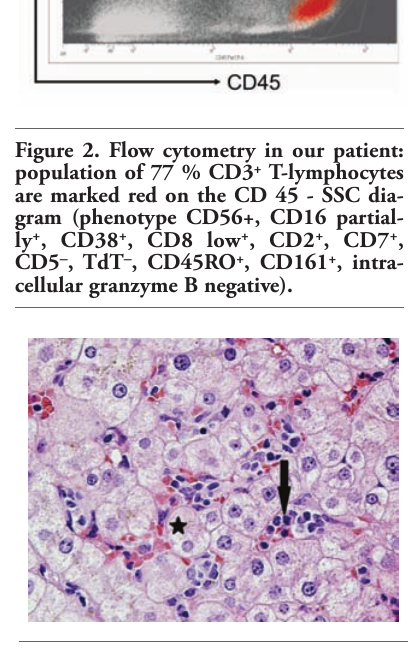
Figure 3. Liver histology of our patient shows lymphoma cells (arrow) between hepatocytes (star) (Haemotoxylin - Eosin stain, x